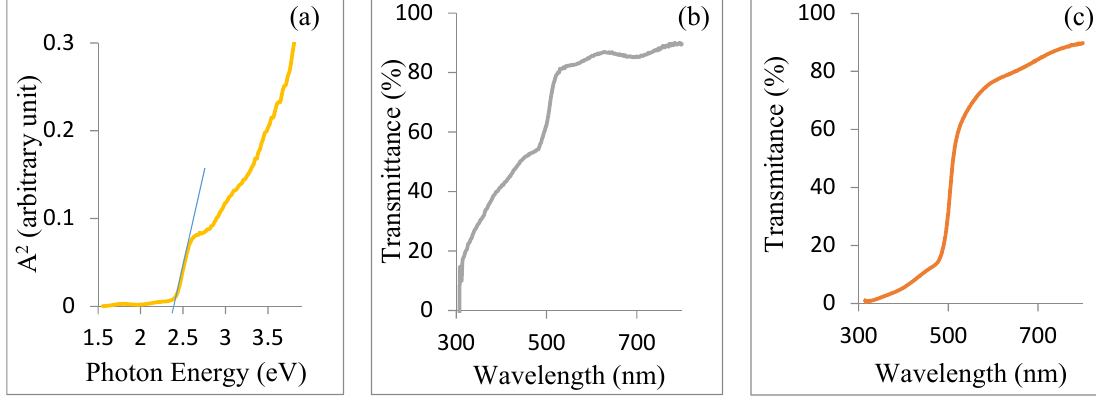
Figure 5. ( a ) Optical absorption of annealed glass/FTO/ZnS/CdS bi-layer; ( b ) transmittance of annealed glass/FTO/ZnS/CdS bi-layer and ( c ) transmittance of glass/FTO/CdS